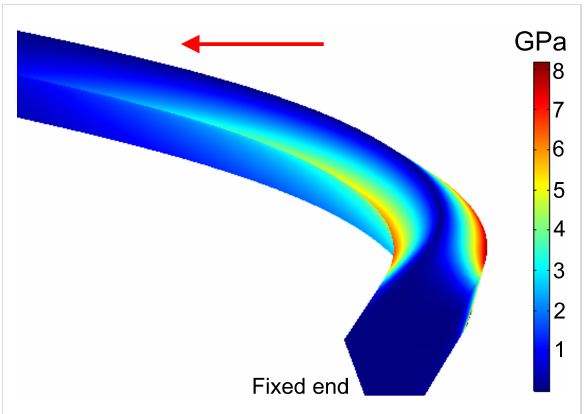
Figure 6: Von Mises stress distribution in a bent Au NW at the critical bending angle, corresponding to the maximal experimental curvature prior to fracture (GPa).